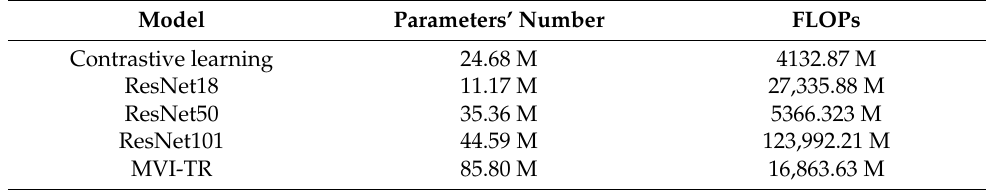
Table 3. Parameters’ number and floating-point operations (FLOPs) of different deep learning models.